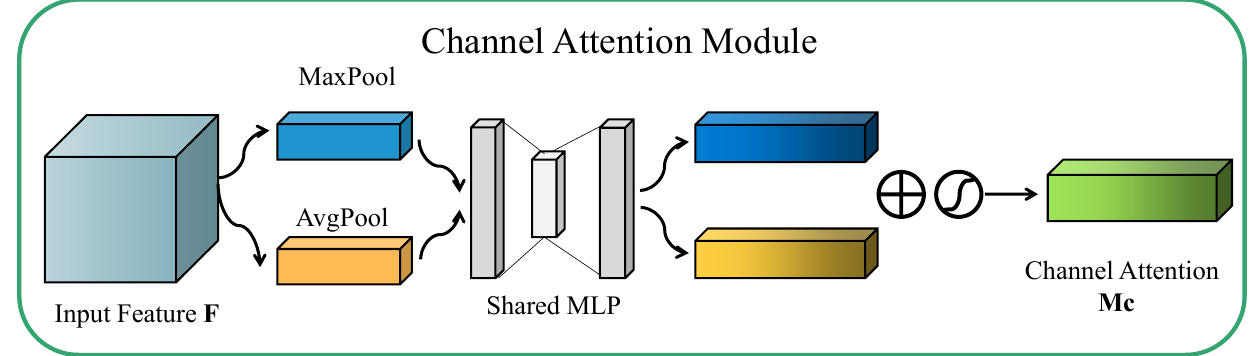
Figure 3. The structure of the Channel Attention Module.